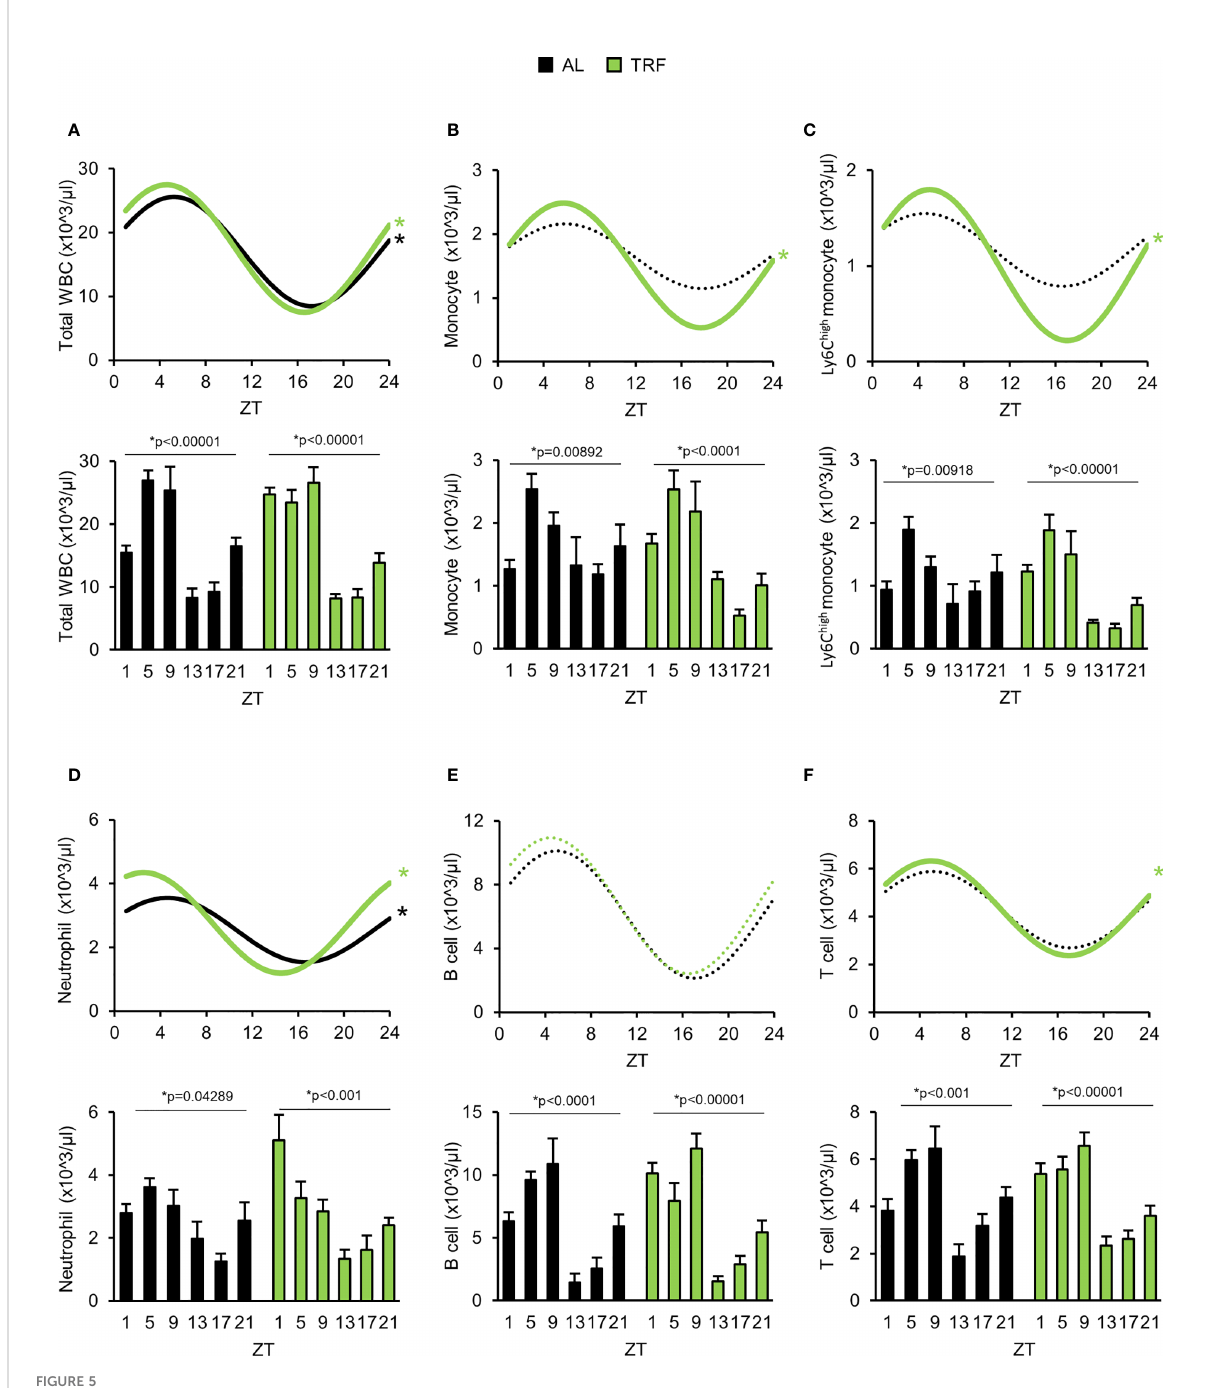
FIGURE 5 Time restricted feeding supports oscillation of the peripheral leukocyte counts. (A-F) Lower panels show peripheral leukocyte counts in the course of the day. Upper panels indicate cosine curve fi t to data showed in lower panels. Total WBC (A) , monocyte (B) , Ly6C high monocyte (C) , neutrophil (D) , B-lymphocyte (E) and T-lymphocyte (F) counts. Data information: In lower panels (A – F) data are presented as mean + SEM (n = 3-9 (AL) and n = 6-11 (TRF), one-way ANOVA, * indicates signi fi cant time effect). In upper panels * and solid lines indicate signi fi cant, fi xed 24-hour period cosine curve fi t with cosinor analysis, whereas dashed lines show non-signi fi cant fi t. Parameters of the fi tted cosine curves are listed in Supplementary Table 5. ZT, Zeitgeber